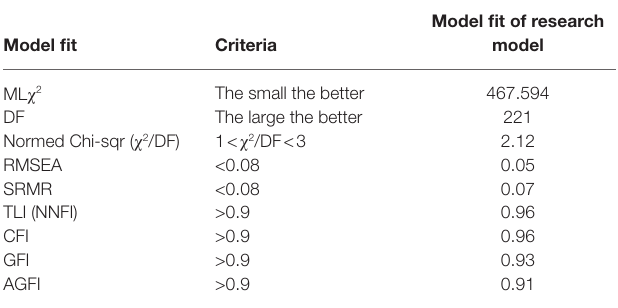
TABLE 4 | Model fit criteria and test results.